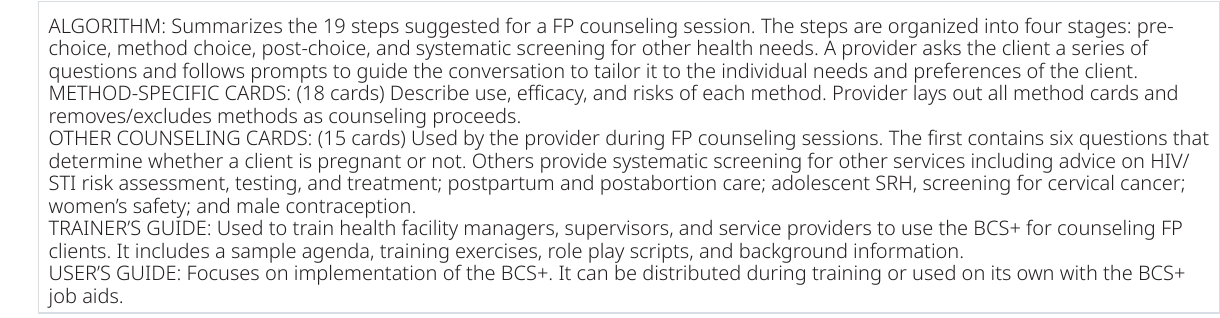
Table 2. Components of the Balanced Counseling Strategy Plus (BCS+) toolkit (Third edition). ALGORITHM: Summarizes the 19 steps suggested for a FP counseling session. The steps are organized into four stages: pre- choice, method choice, post-choice, and systematic screening for other health needs. A provider asks the client a series of questions and follows prompts to guide the conversation to tailor it to the individual needs and preferences of the client. METHOD-SPECIFIC CARDS: (18 cards) Describe use, efficacy, and risks of each method. Provider lays out all method cards and removes/excludes methods as counseling proceeds. OTHER COUNSELING CARDS: (15 cards) Used by the provider during FP counseling sessions. The first contains six questions that determine whether a client is pregnant or not. Others provide systematic screening for other services including advice on HIV/ STI risk assessment, testing, and treatment; postpartum and postabortion care; adolescent SRH, screening for cervical cancer; women’s safety; and male contraception. TRAINER’S GUIDE: Used to train health facility managers, supervisors, and service providers to use the BCS+ for counseling FP clients. It includes a sample agenda, training exercises, role play scripts, and background information. USER’S GUIDE: Focuses on implementation of the BCS+. It can be distributed during training or used on its own with the BCS+ job